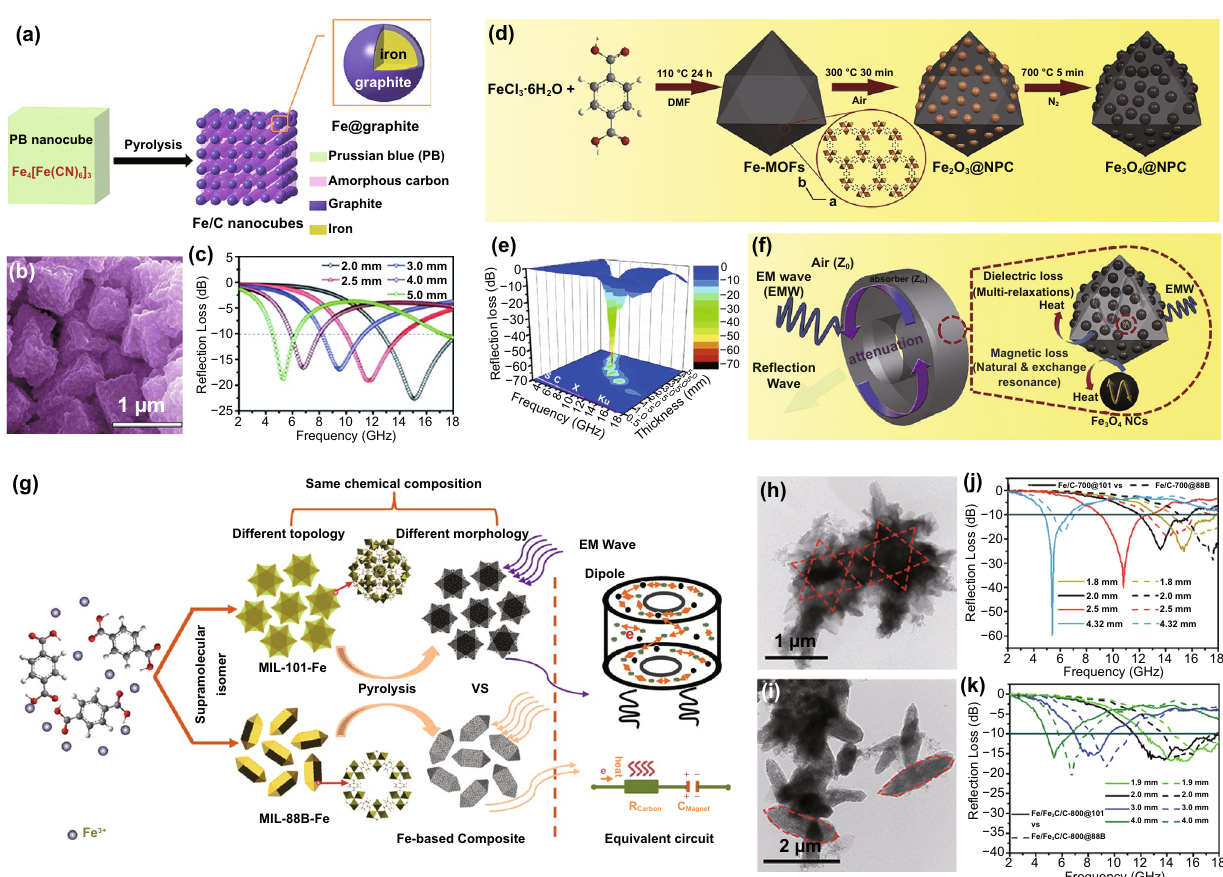
Fig. 4 a Synthesis method, b SEM image and c RL-f curves of Fe/C nanocubes. Reprinted with permission from Ref. [92] d Schematic diagram of the preparation and e RL-f curves of Fe 3 O 4 @NPC. f Schematic illustration of the MA mechanism of Fe 3 O 4 @NPC. Reprinted with permission from Ref. [83] g Schematic illustration for the synthetic process of the two kinds of FeC nanocomposites. TEM images and RL-f curves of h, j FeC-800@101 and i, k FeC-800@88B. Reprinted with permission from Ref.